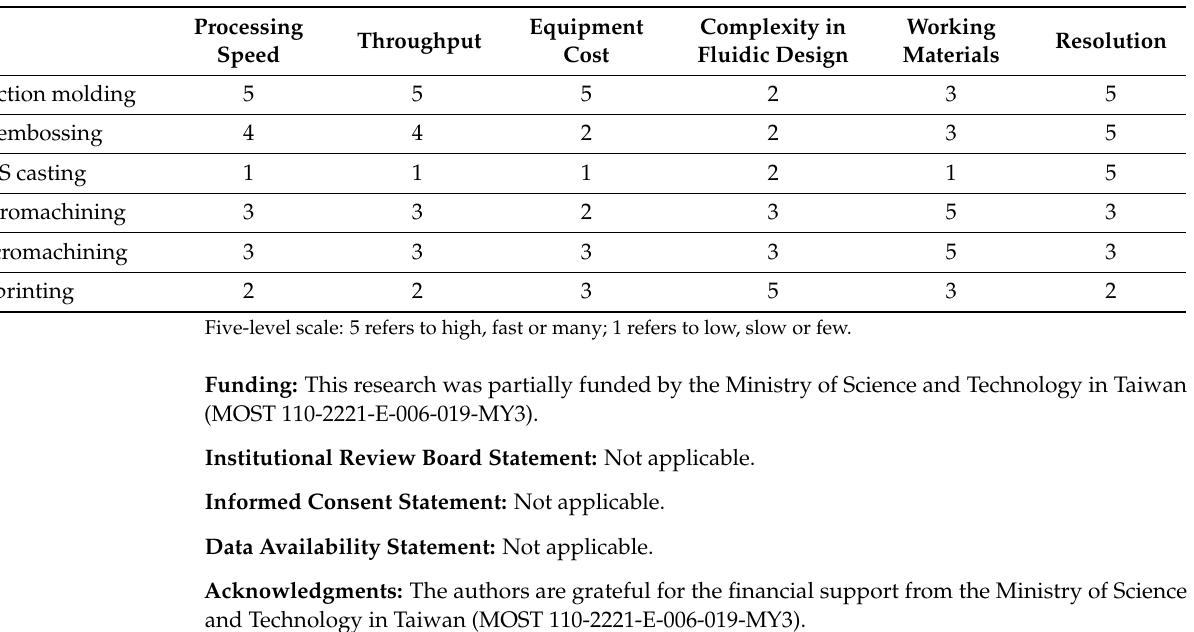
Table 1. Comparison of fabrication techniques for polymer